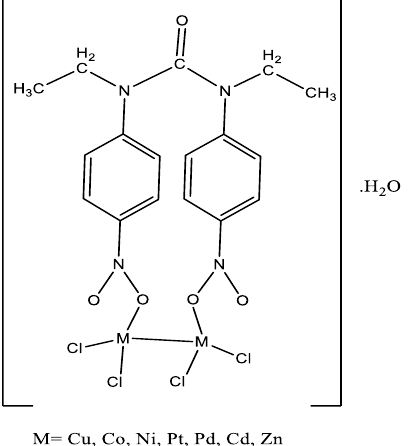
Figure 4. Proposed structure of metal complexes.